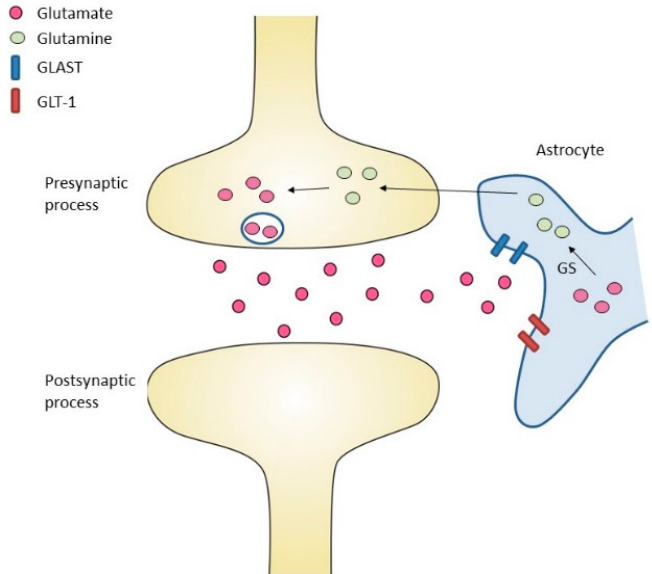
Figure 3. The role of astrocytes in glutamate uptake. Glutamate is released into the synaptic cleft. Glutamate transporter 1 (GLT-1) and L-glutamate/L-aspartate transporter (GLAST) transfer gluta- mate into astrocytic cells. Glutamine synthetase (GS) converts glutamate into glutamine. Glutamine is released from astrocytes via specific transporters and then taken up into neurons. In the neuron, glutamine is converted to